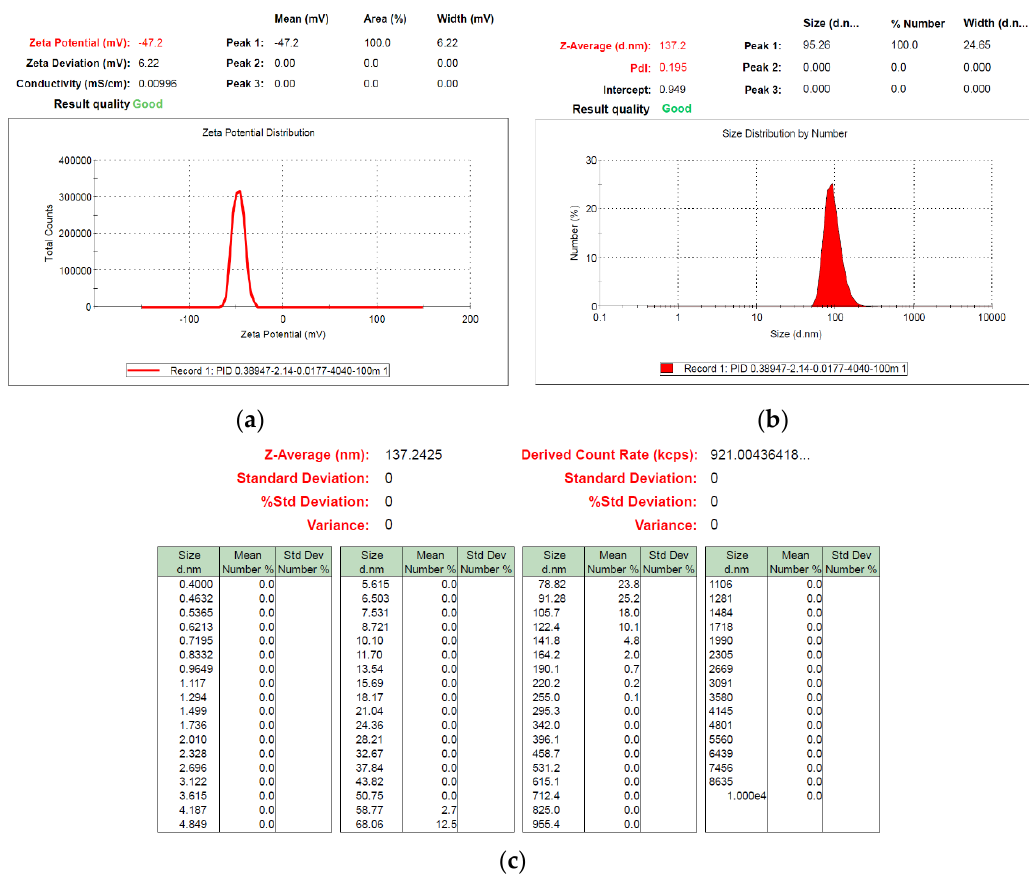
Figure 13. Analysis of C40-40-100 min colloids: ( a ) ζ potential; ( b ) particle size distribution; and ( c ) particle size statistics report by number of colloids.